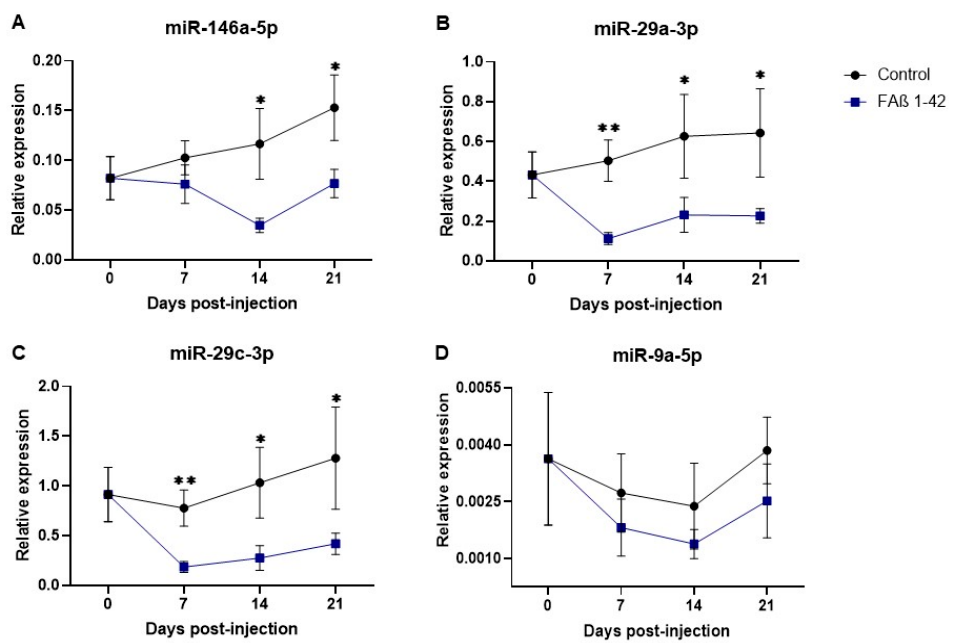
Figure 5. Kinetics of circulating microRNAs detected in the serum of rats infused with FA β 1–42 peptide solution used at 2.5 µ g/ µ L final concentration. The quantification of miRNAs in serum of rats was investigated at 0, 7, 14, and 21 days post-infusion with FA β 1–42 peptides or with PBS control solutions. Relative expression profiles of ( A ) miR-146a-5p, ( B ) miR-29a-3p, ( C ) miR-29c-3p, and ( D ) miR-9a-5p quantified by qRT-PCR performed in triplicates and expressed as mean ± SEM ( n = 8 rats per group and for each time point). Statistical comparisons between groups at each time were made using the Mann–Whitney test. * p ≤ 0.05, ** p ≤ 0.01.